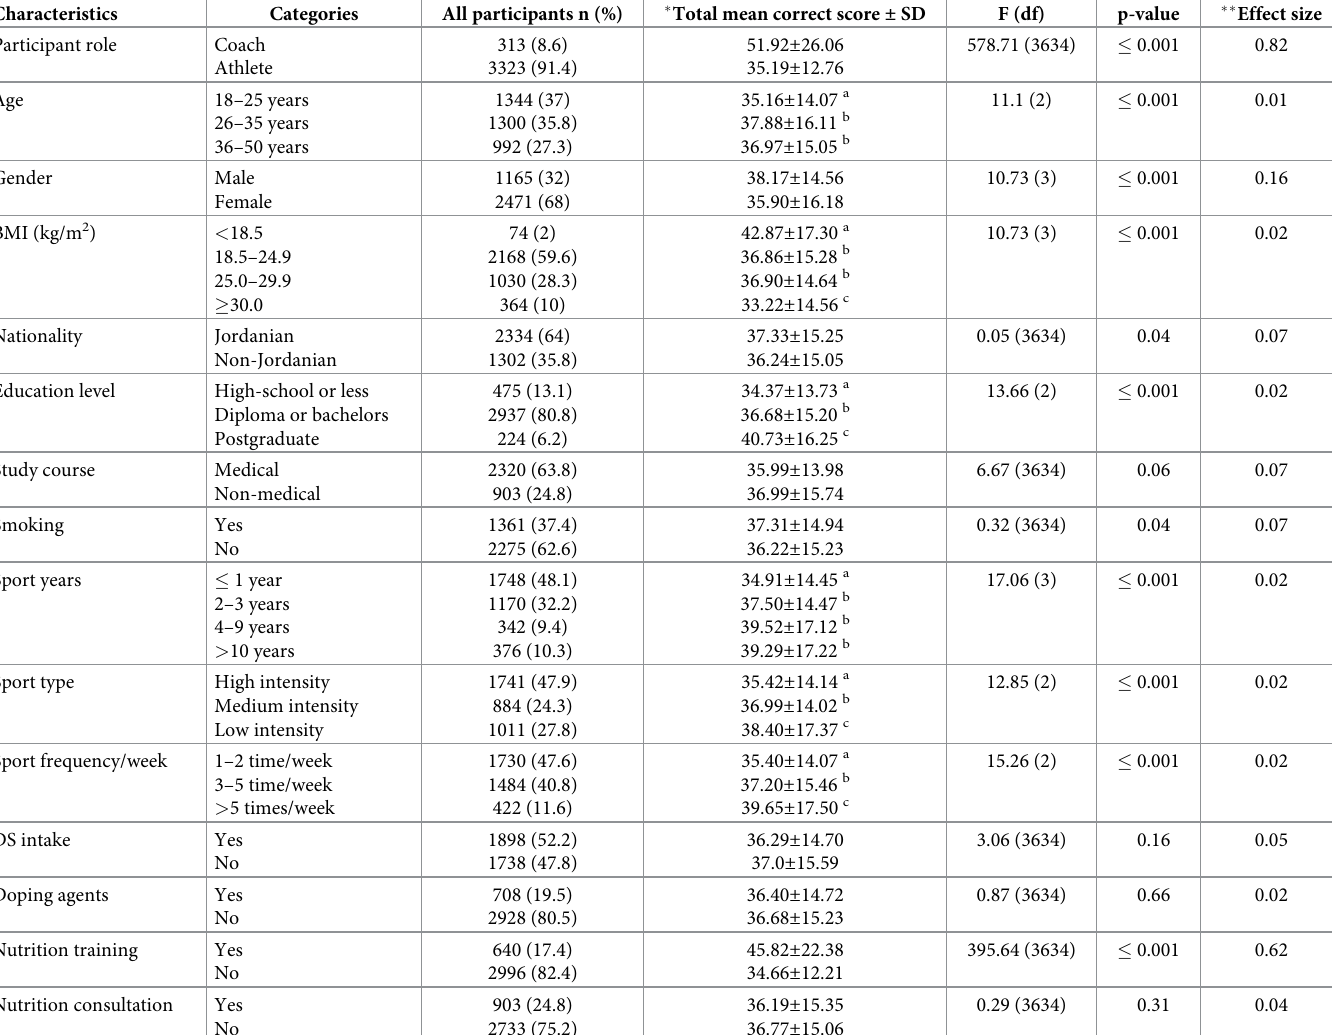
Table 1. Demographic and lifestyle characteristics of the study participants and univariate analysis of influence of factors on mean total nutrition knowledge score obtained on the Abridged Nutrition Knowledge Questionnaire (ANSKQ) (n = 3636).